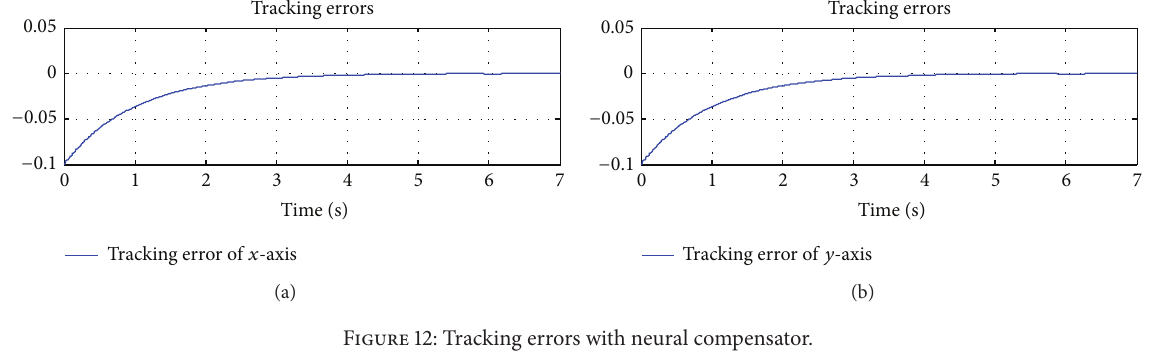
Figure 12: Tracking errors with neural compensator.